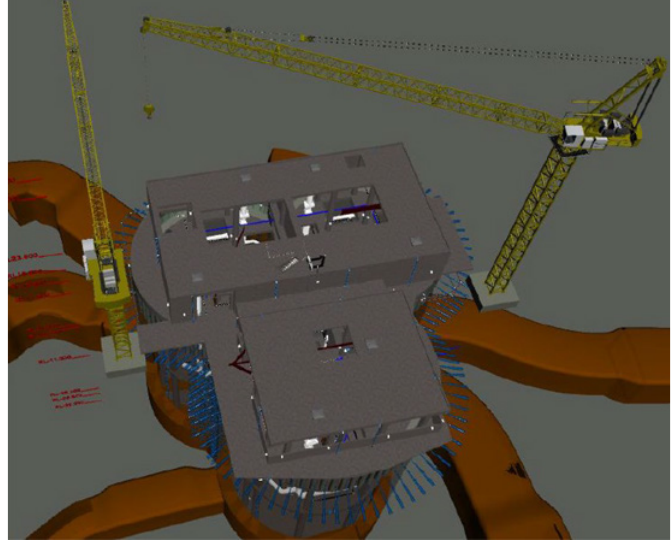
Figure 3 Vent tunnels interface with the vent